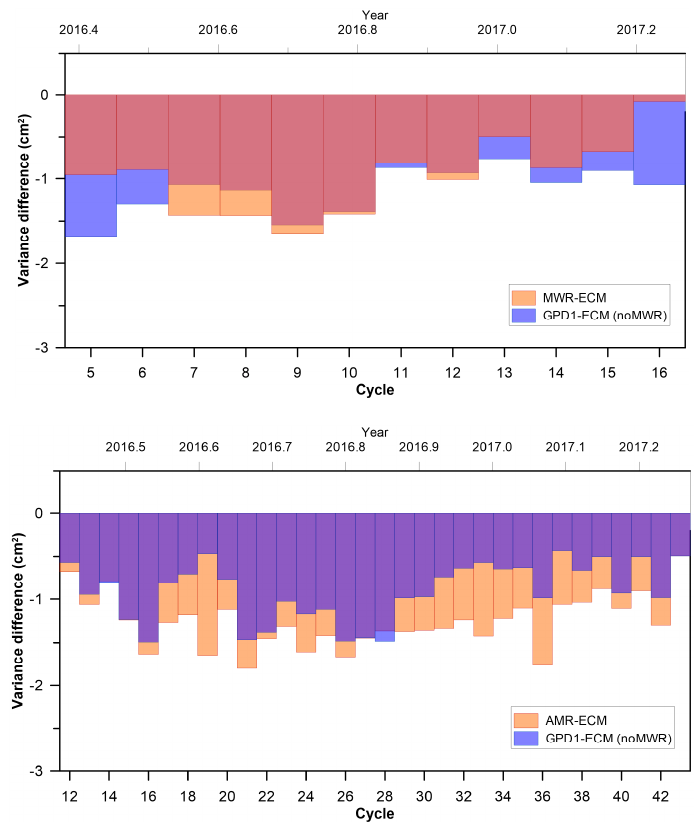
Figure 19. Temporal evolution of weighted along ‐ track SLA variance differences for SLA datasets computed using the WTC from the on ‐ board MWR and from ECMWF (orange) and those from GPD1 and ECMWF (blue) for S3A ( Top ) and J3 ( Bottom ). Only points with a valid MWR have been used.